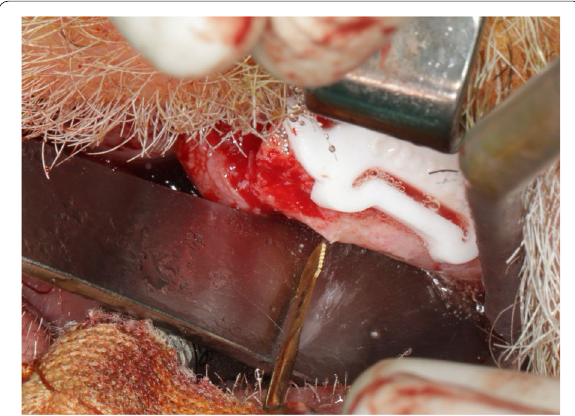
Fig. 4 Leveling and trimming of the alveolar crest. Intraoperative view showing the serrated tip of the piezosurgery device (Mectron, Carasco, Italy) and the resection guide for trimming the alveolar crest prior to IPS‑preprosthetic ®